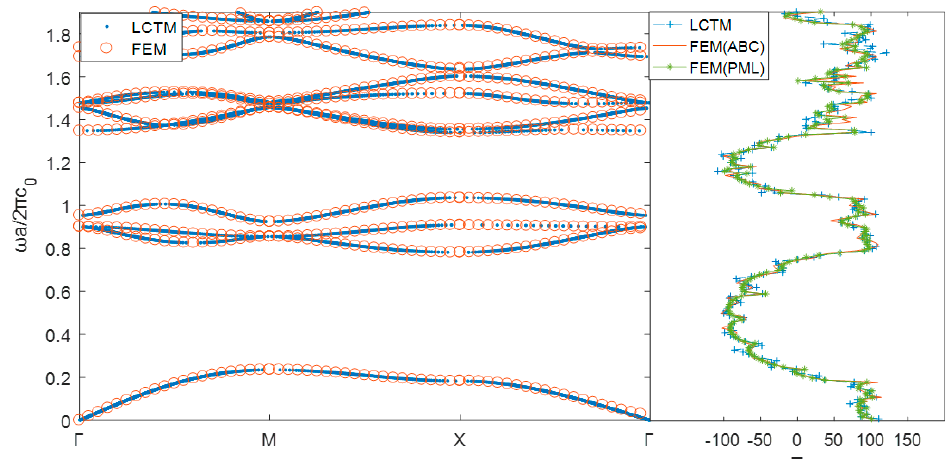
Γ− direction and